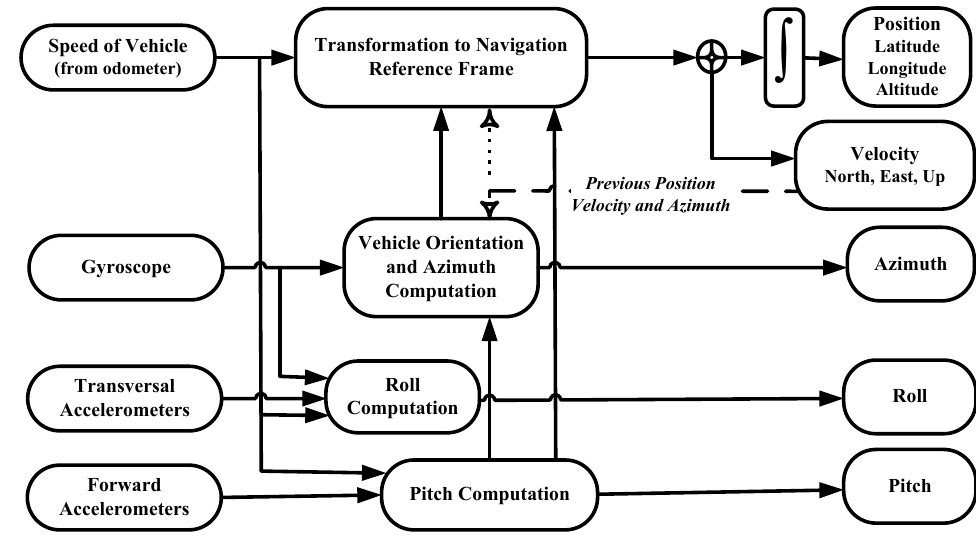
Figure 6. Block diagram of 3D